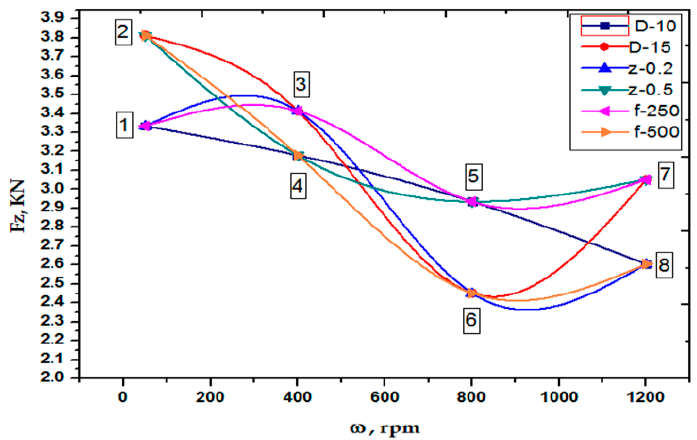
Figure 21. Graphical representation of the interaction effects on the axial force.